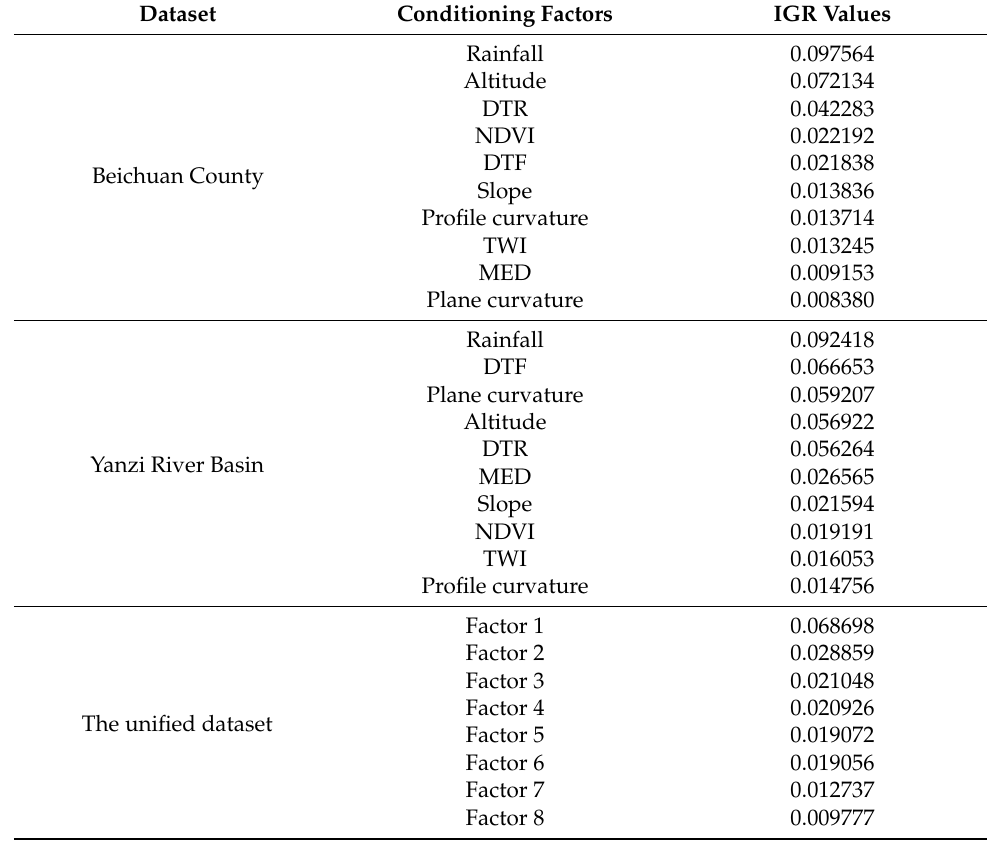
Table 1. The IGR values of different